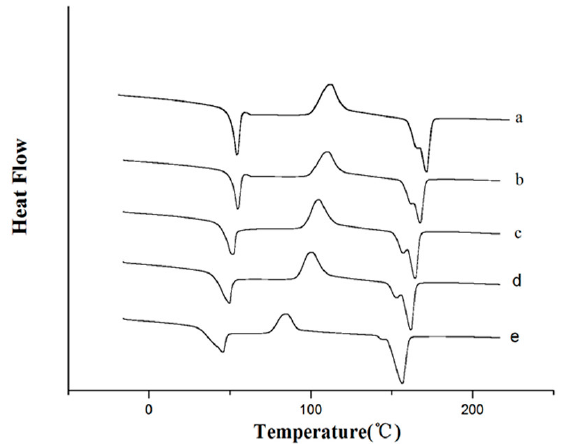
Figure 2. Differential scanning calorimetry curves of poly (lactic acid)/poly(trimethylene carbonate)/ oregano essential oil composite films ( a ) PLA/PTMC; ( b ) PLA/PTMC/O3; ( c ) PLA/PTMC/O6; ( d ) PLA/PTMC/O9 and ( e ) PLA/PTMC/O12.